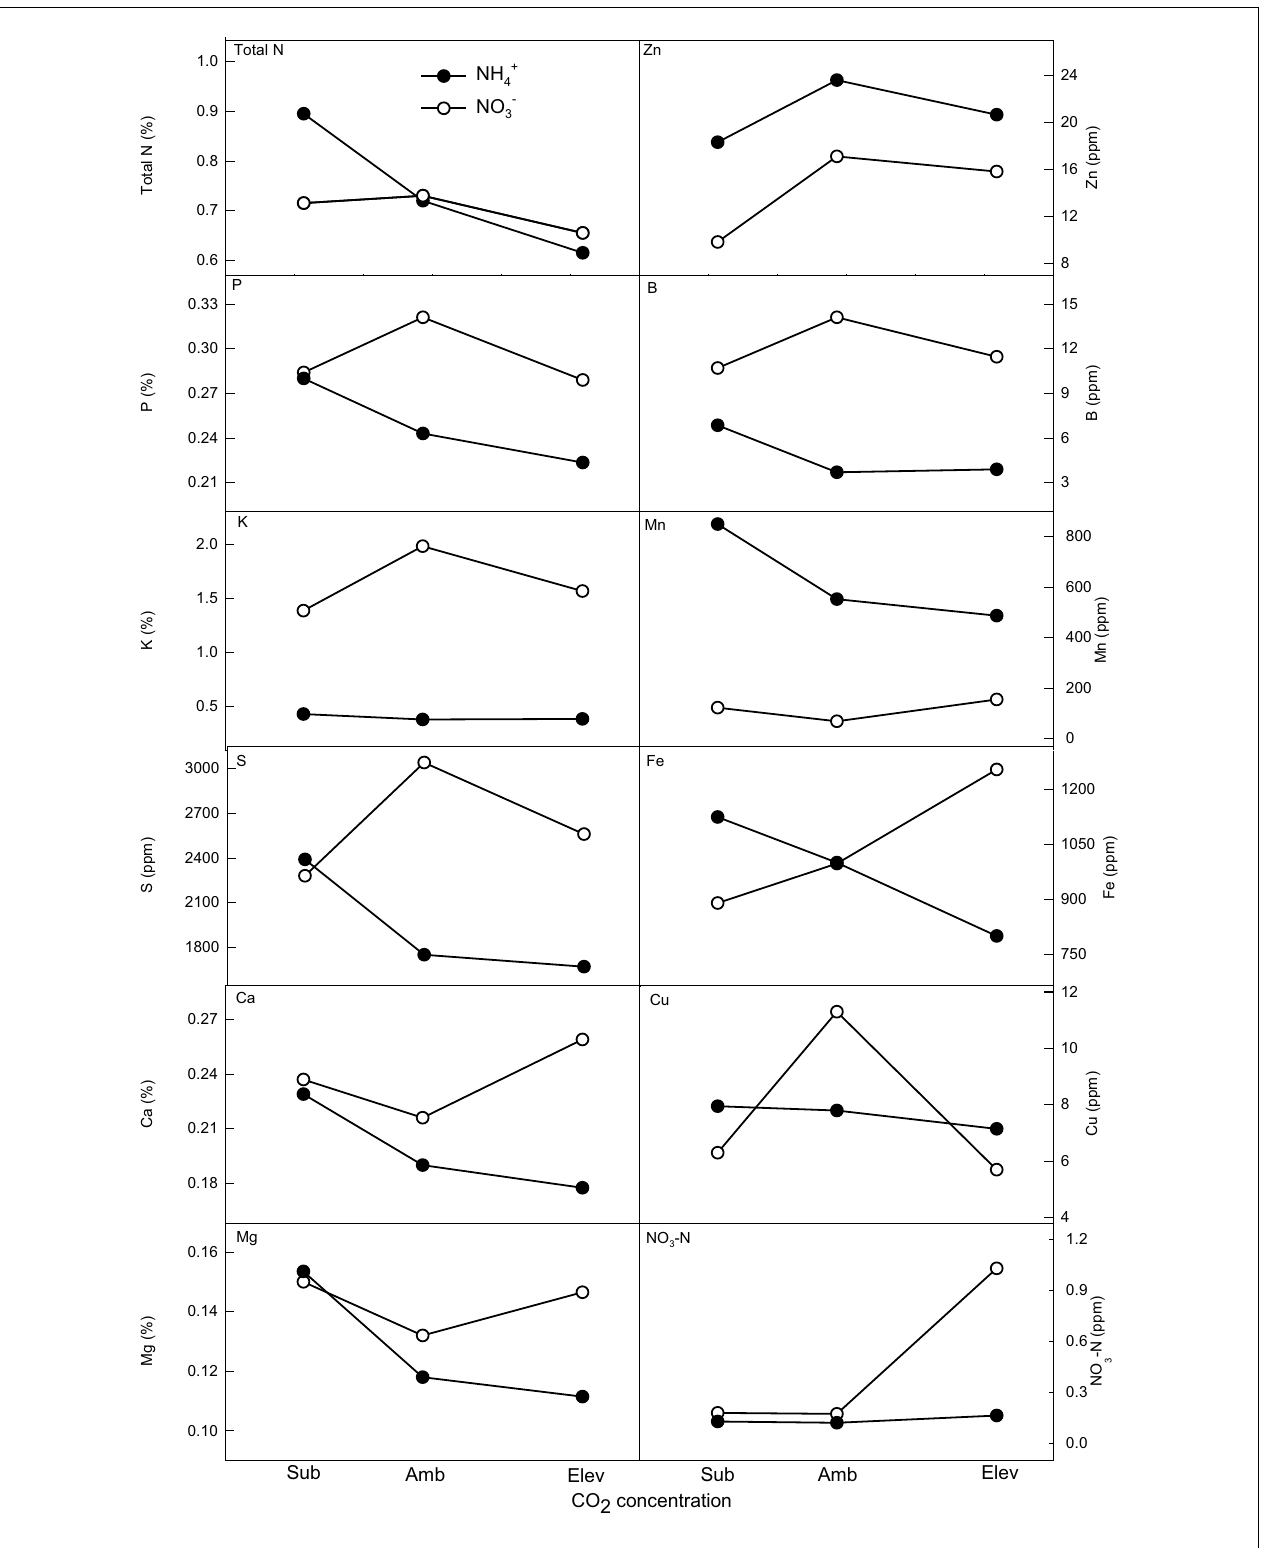
( n = 10). Macro- and micronutrients are listed in the upper left of each frame. The lack of error bars reflects that the root mass for each treatment was bulked and analyzed as a